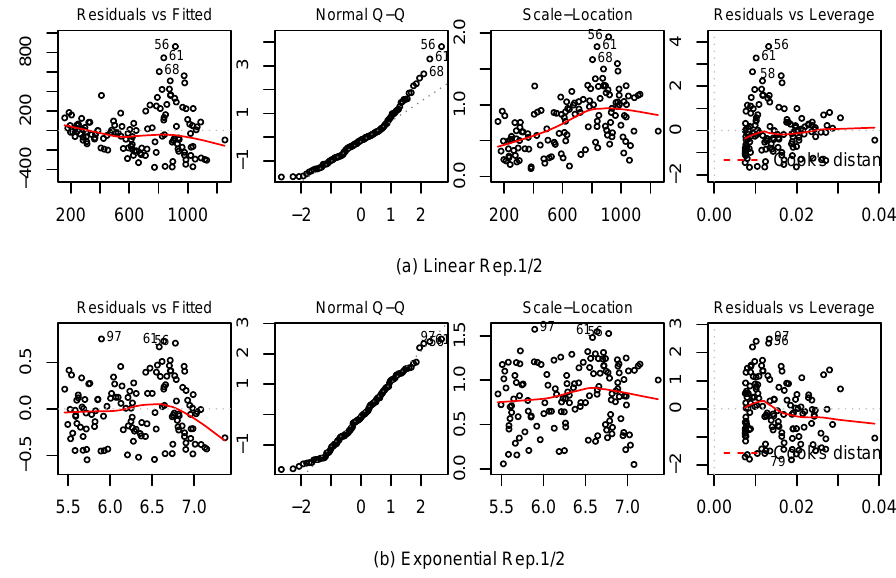
Figure 4. Diagnostic plots for two exemplary regressions: ( a ) linear regression for Repetitions 1 and 2; and ( b ) exponential regression for Repetitions 1 and